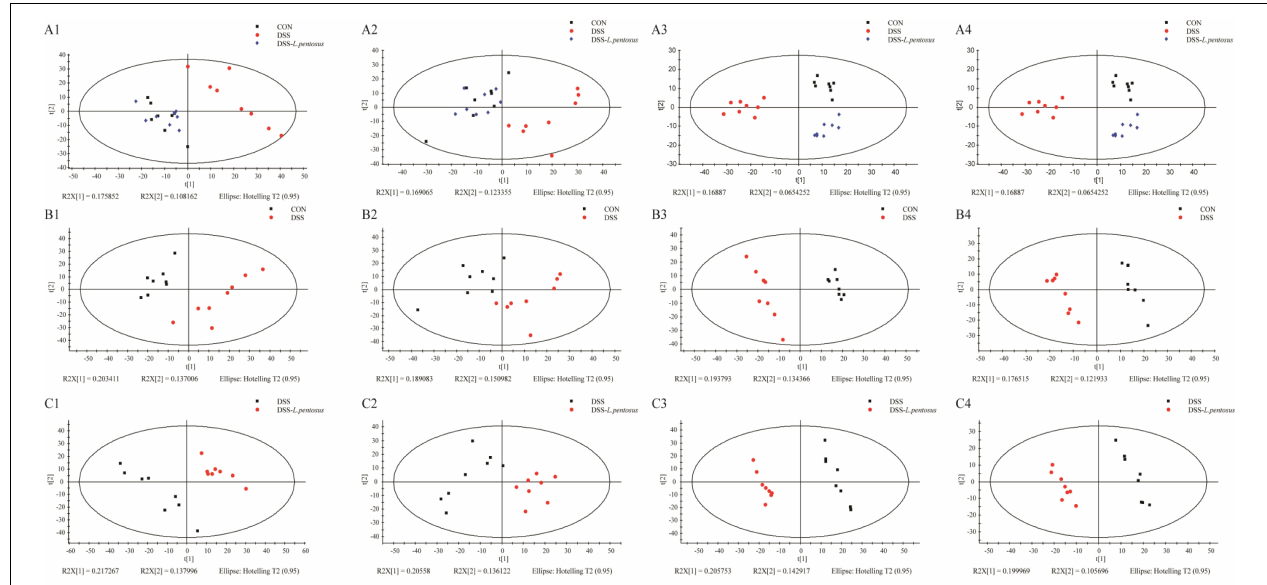
FIGURE 3 | Plots of the multivariate statistical comparisons between groups. (A1) PCA score plot of all samples (ESI+); (A2) PCA score plot of all samples (ESI-); (A3) PLS-DA score plot of all samples (ESI+); (A4) PLS-DA score plot of all samples (ESI-); (B1) PCA score plot of CON-DSS (ESI+); (B2) PCA score plot of CON-DSS (ESI-); (B3) PLS-DA score plot of CON-DSS (ESI+); (B4) PLS-DA score plot of CON-DSS(ESI-); (C1) PCA score plot of DSS-(DSS- L. pentosus ) (ESI+); (C2) PCA score plot of DSS-(DSS- L. pentosus ) (ESI-); (C3) PLS-DA score plot of DSS-(DSS- L. pentosus ) (ESI+); (C4) PLS-DA score plot of DSS-(DSS- L. pentosus )